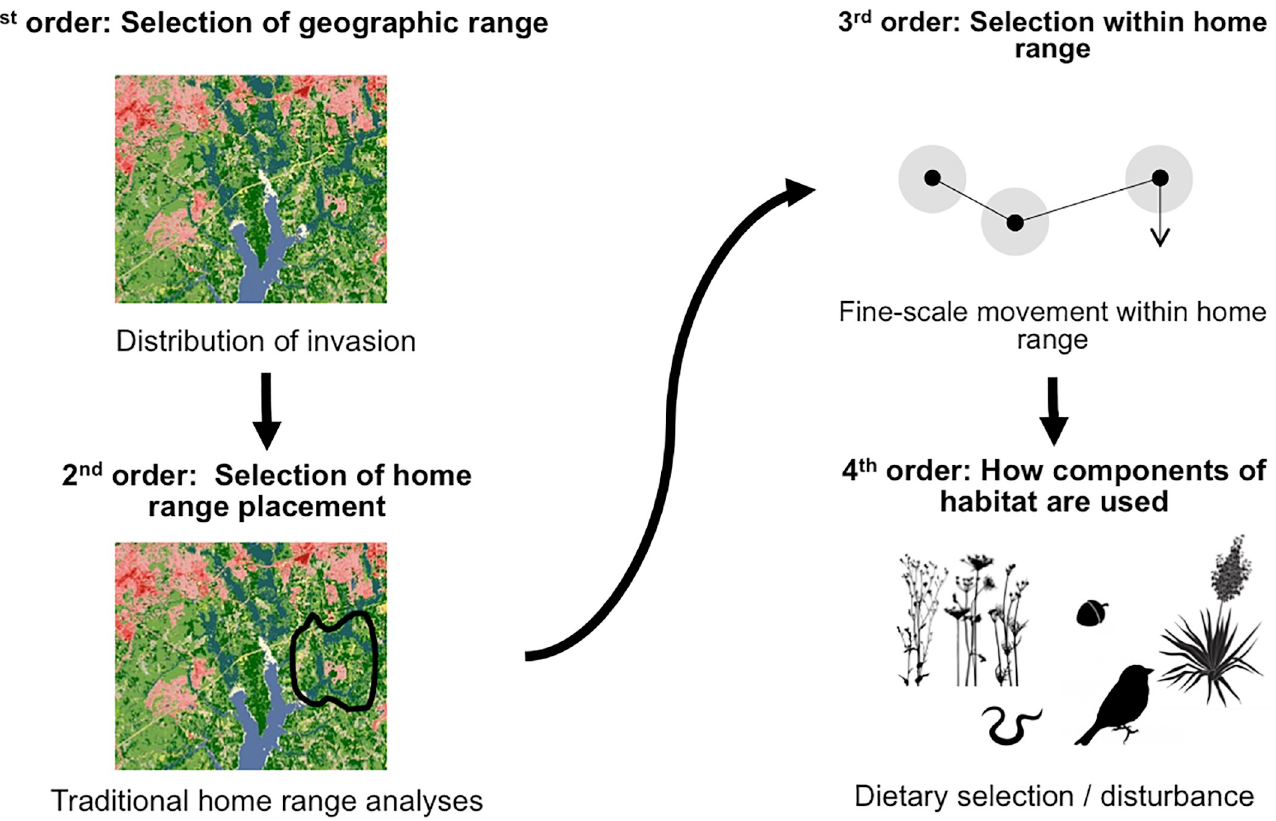
Fig 1. Diagram based on Johnson (1980) [6], indicating four scales of resource selection and associated application to invasive species ecology. At the first order, species distribution (green) can be identified at the landscape scale, compared to second order selection where the location of an individual’s home range is known within the landscape. Third order selection can determine selection within the home range based on fine-scale movement behavior, and fourth order selection involves investigations into how invasive species use or disturb habitats at the finest